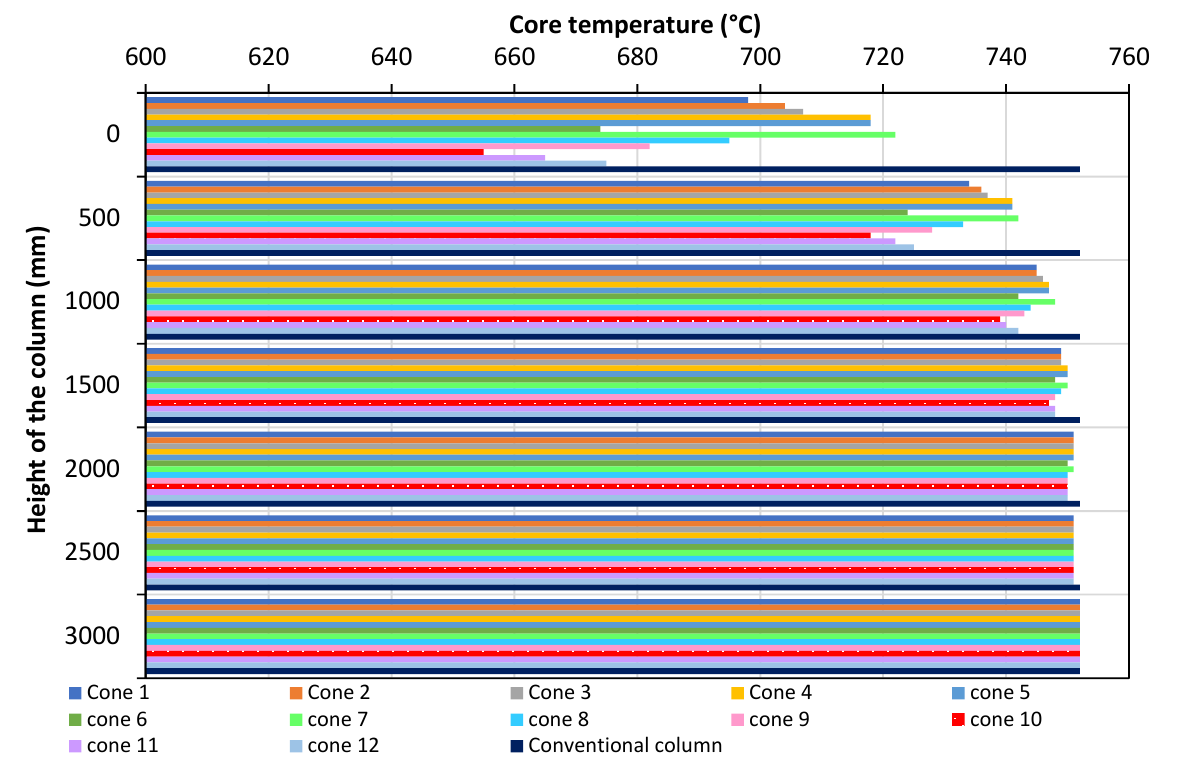
Figure 8. Comparison of the core temperatures with respect to height for the columns. For better representation, the heat dissipation of the column specimen with cone 10 and the conventional column was compared and is shown in Figure 9. At the top of the column, the temperature of the conventional column was 752°C, and the column specimen with cone 10 was 655°C. The temperature of the column specimen with cone 10 tends to be 14.8% less than the temperature of the conventional column at the top. This heat dissi- pation works similarly to the fire protection technique. Implementing a simple shape could prevent the collapse of the column. A pictorial representation of the heat release contours of the conventional column and mimicked column with cone 10 is shown in Fig- ure 10.